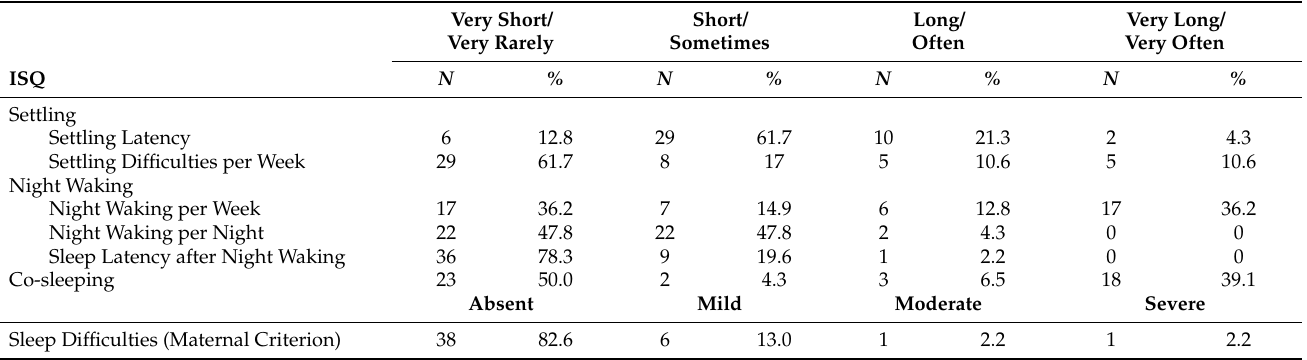
Table A1. Frequency of Late Talkers’ Perceived Nighttime Sleep Characteristics Assessed with